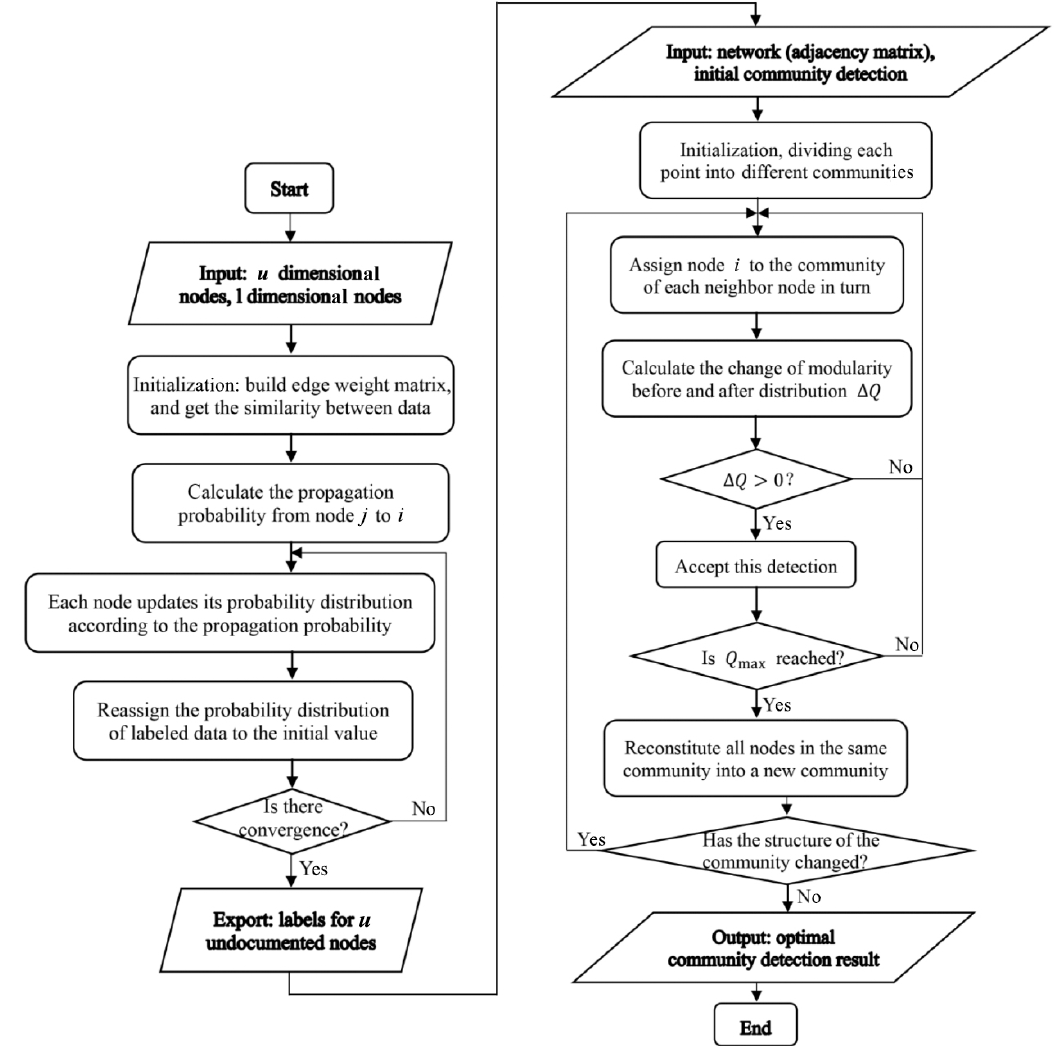
Fig. 1 Flow chart of semi-supervised community detection algorithm based on label propagation and modularity optimization algorithm combining a priori information of community-core’s initial